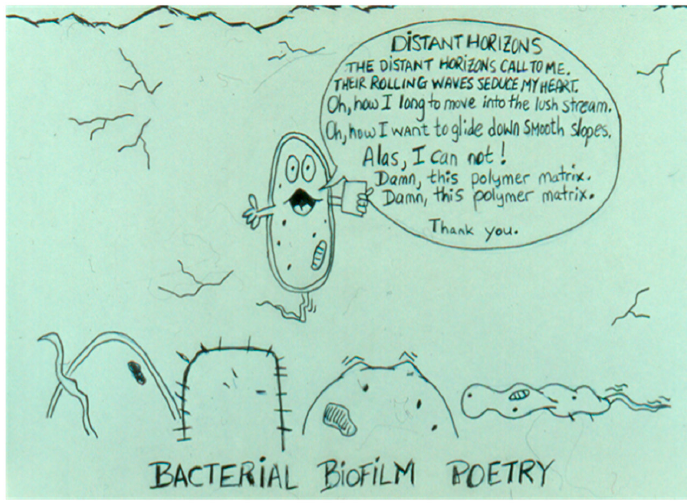
Figure 6. The dammned polymer matrix (J.C. Bryers, Univ. Washington, with permission).